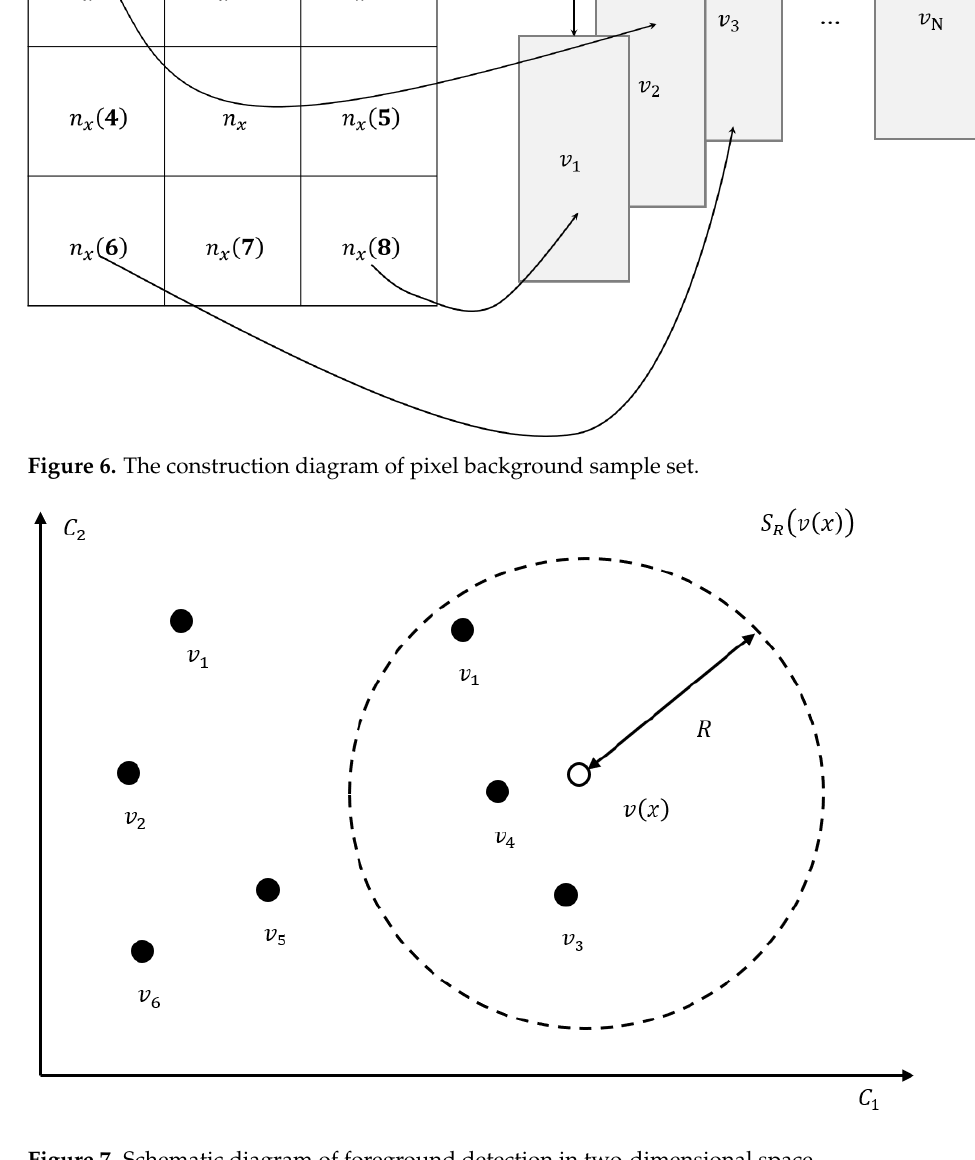
Figure 7. Schematic diagram of foreground detection in two-dimensional